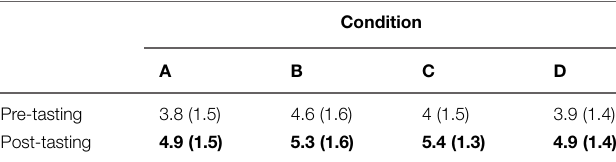
TABLE 2 | Comparison of rates (Means and SD ) before and after tasting the